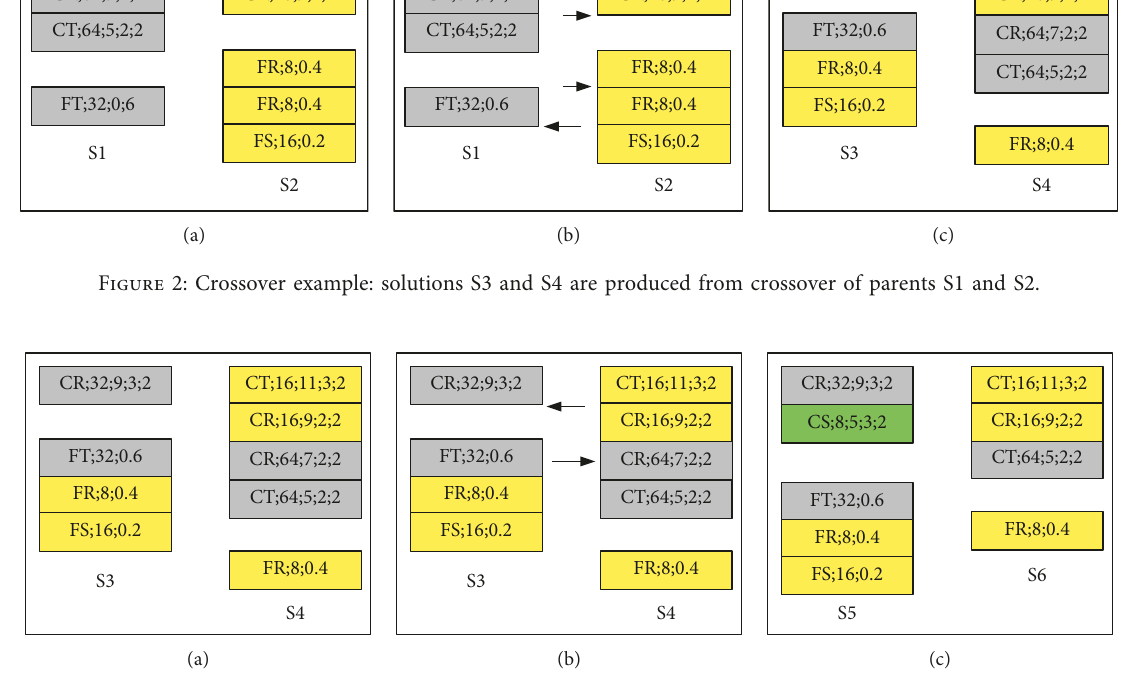
Figure 3: Mutation example: solutions S5 and S6 are produced after mutation of S3 and